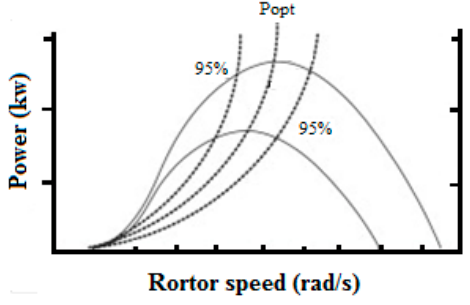
Figure 19. A de-loaded active power curves by changing the rotor speed.